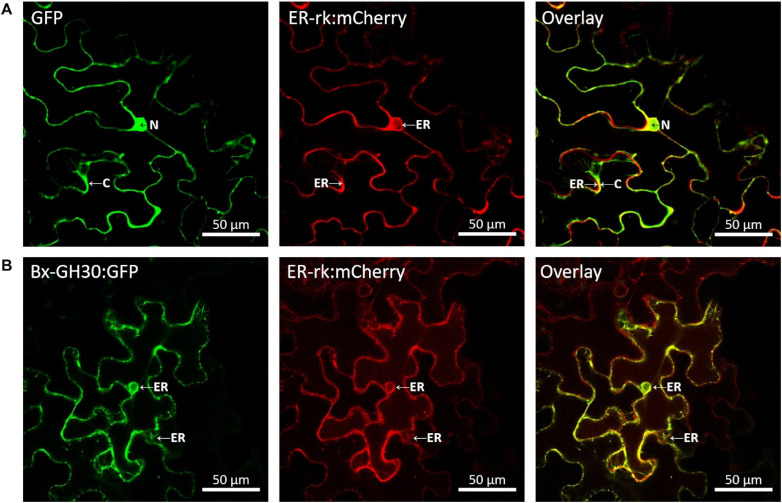
Localization of Bx-GH30 in plant cells. Confocal images of GFP (A) and Bx-GH30 (B) infiltrated into N. benthamiana leaves, together with an mCherry-labeled endoplasmic reticulum marker (ER-rk CD3-959). For confocal laser scanning microscopy, samples were taken at 3 days post-inoculation, and fluorescent channels were scanned sequentially. GFP fluorescence is shown in green (left panel) and mCherry fluorescence is shown in red (middle panel). The overlay of green and red signals appears yellow (right panel). N, nucleus; C, cytoplasm; ER, endoplasmic reticulum. Scale bar = 50 μm.